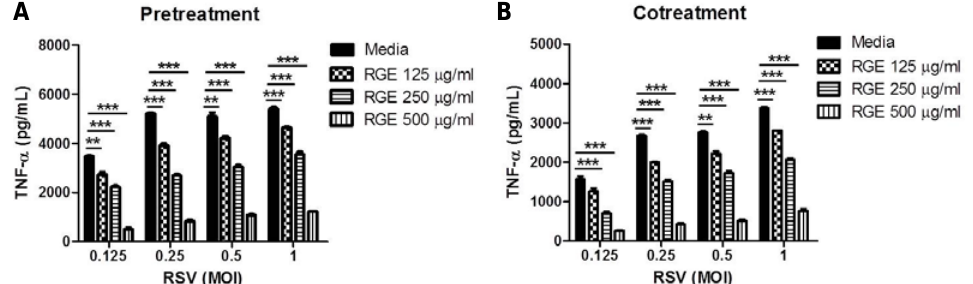
Figure 3. Red ginseng extract (RGE) inhibits respiratory syncytial virus (RSV)-induced inflammatory cytokine production in macrophages. RAW264.7 macrophages were mock-infected or infected with RSV at different MOIs. RAW264.7 macrophages were treated with RGE 24 h prior to infection or during the infection period. Concentrations of TNF-α in the culture supernatants were determined using ELISA kit. ( A ) Pre-treatment of RGE on RAW264.7 macrophages infected with RSV at different MOIs; ( B ) Co-treatment of RGE on RAW264.7 macrophages infected with RSV at different MOIs. Values are the mean ±